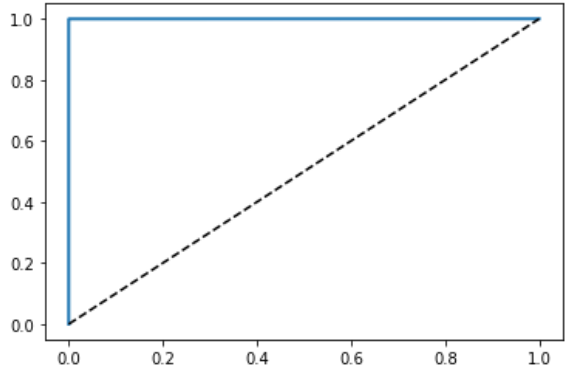
Figure 31. Changing the DDoS dataset ROC.